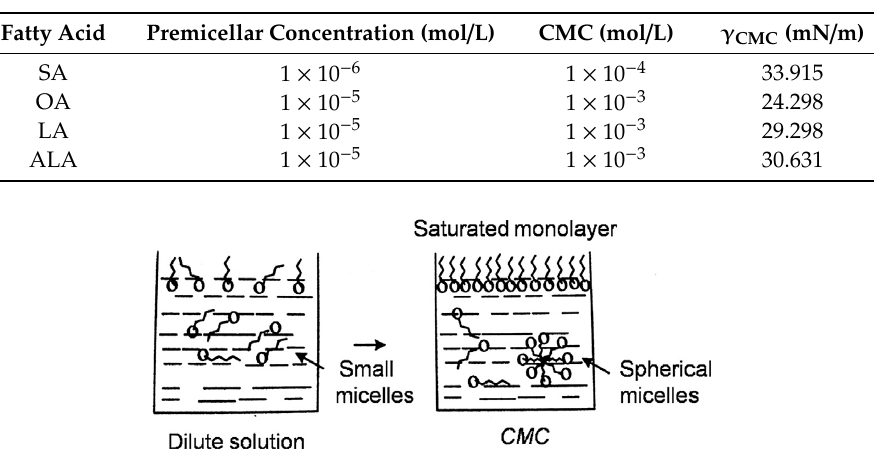
Figure 4. Micellization of the surfactant solution [43].